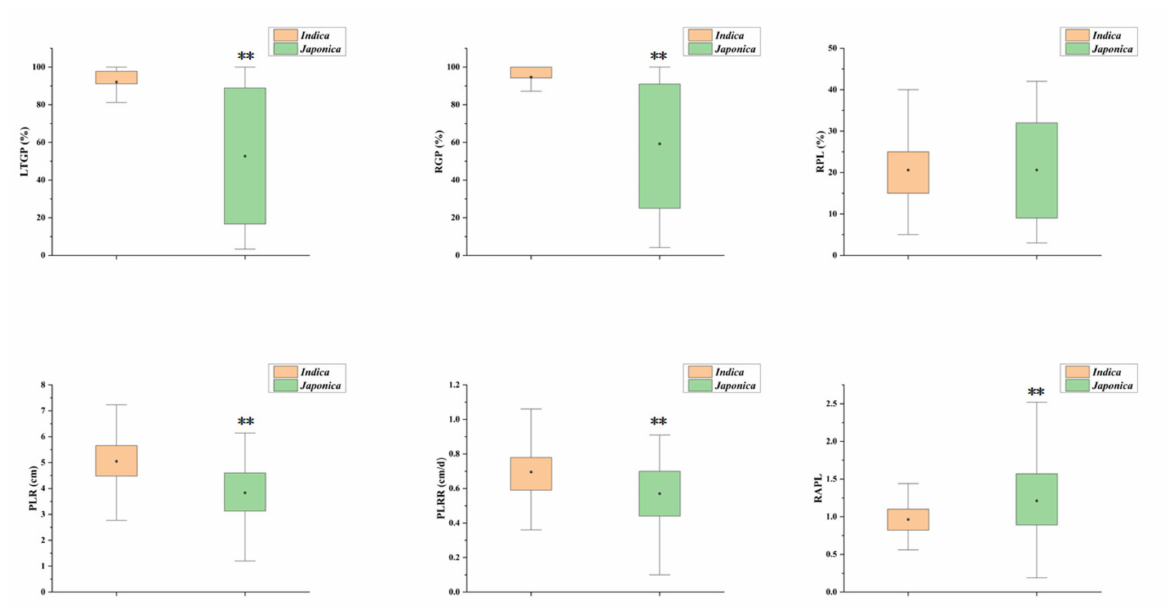
Figure 2. Comparison of LTG indices among different subgroups. The vertical axis in each subfigures represents the range of LTG index values, yellow boxes represent indica , green boxes represent japonica , and black dots in the boxes represent average values. ** Indicates significance at the 1% level.